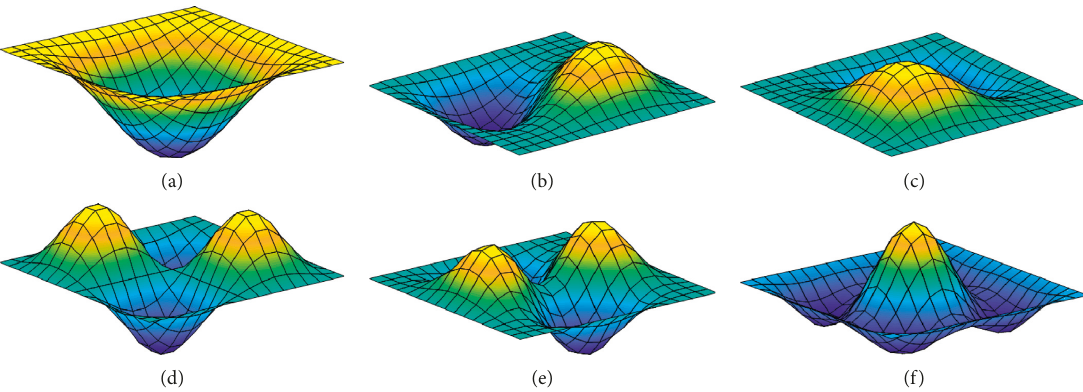
Figure 17: The first six mode shapes of a two-layer square CCCC composite plate. (a) Mode 1. (b) Mode 2. (c) Mode 3. (d) Mode 4. (e) Mode 5. (f) Mode 6.